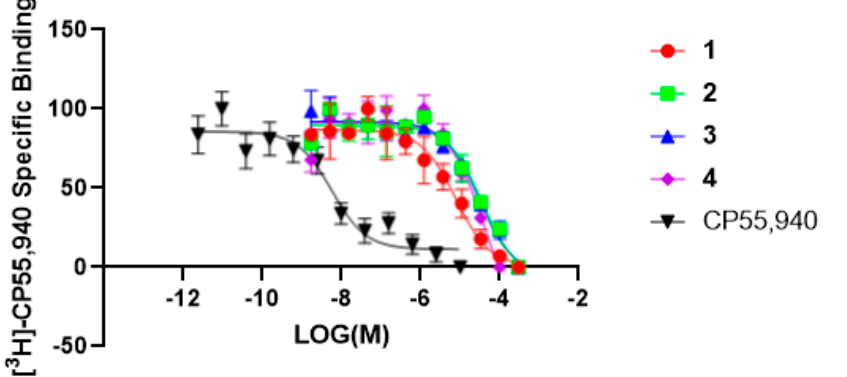
Figure 2. The radioligand displacement curves were obtained for compounds ( 1 – 4 ) for the CB1R. CP55,940 was used as a positive control.